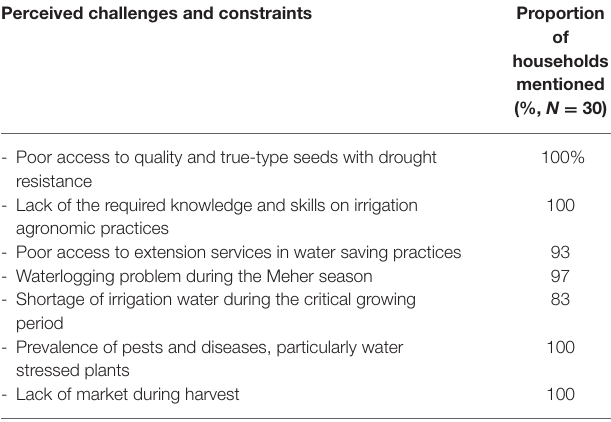
TABLE 6 | Perceived challenges and constraints for adopting deficit irrigation by smallholder irrigation user farmers at Barneb 2 small-scale irrigation scheme in Northeastern